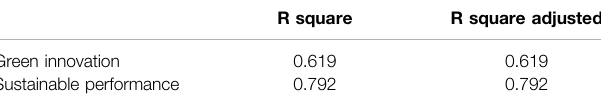
TABLE 5 | Predictive accuracy.